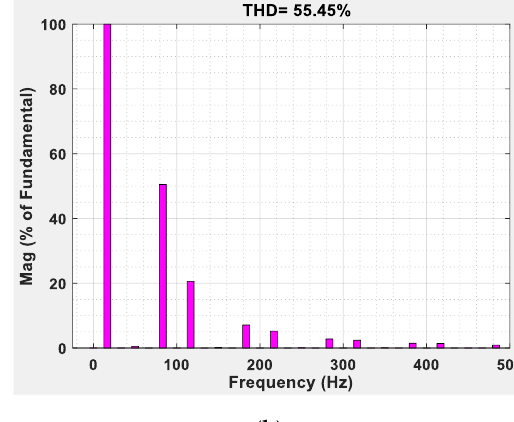
Figure 8. Waveforms of the output voltage with output voltage regulation capabilities for output frequency requirement: ( a ) one-half; ( b ) one-third; and ( c ) one-fourth.